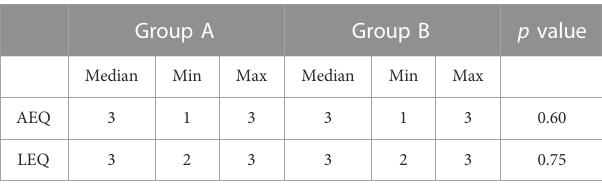
TABLE 2 Results of the comparison between two groups.